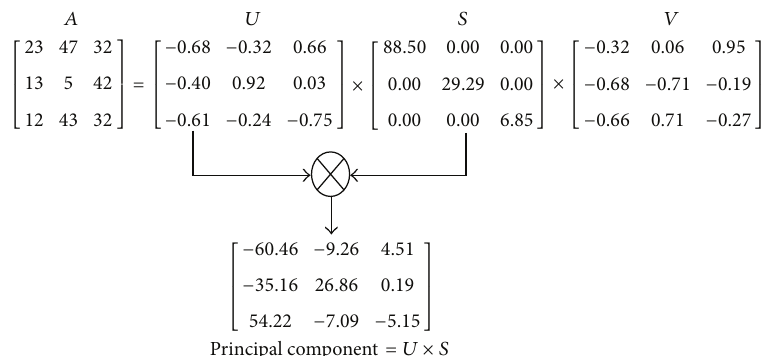
Figure 4: Illustration of SVD and its principal component.